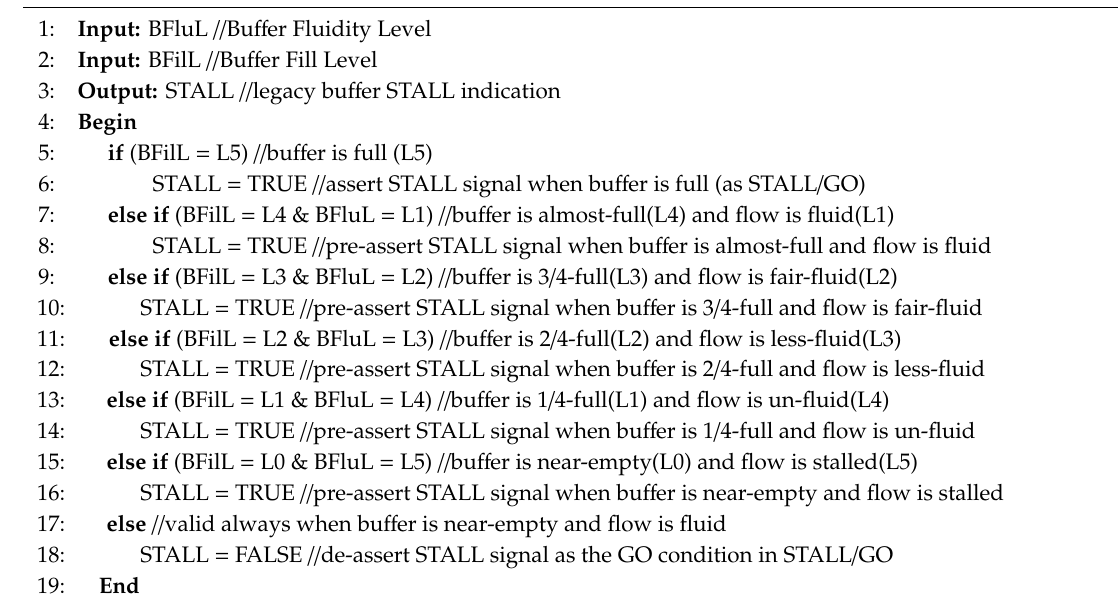
Algorithm 2 Bu ff er-Cognition-Level Flow Control (BCogL.FC)